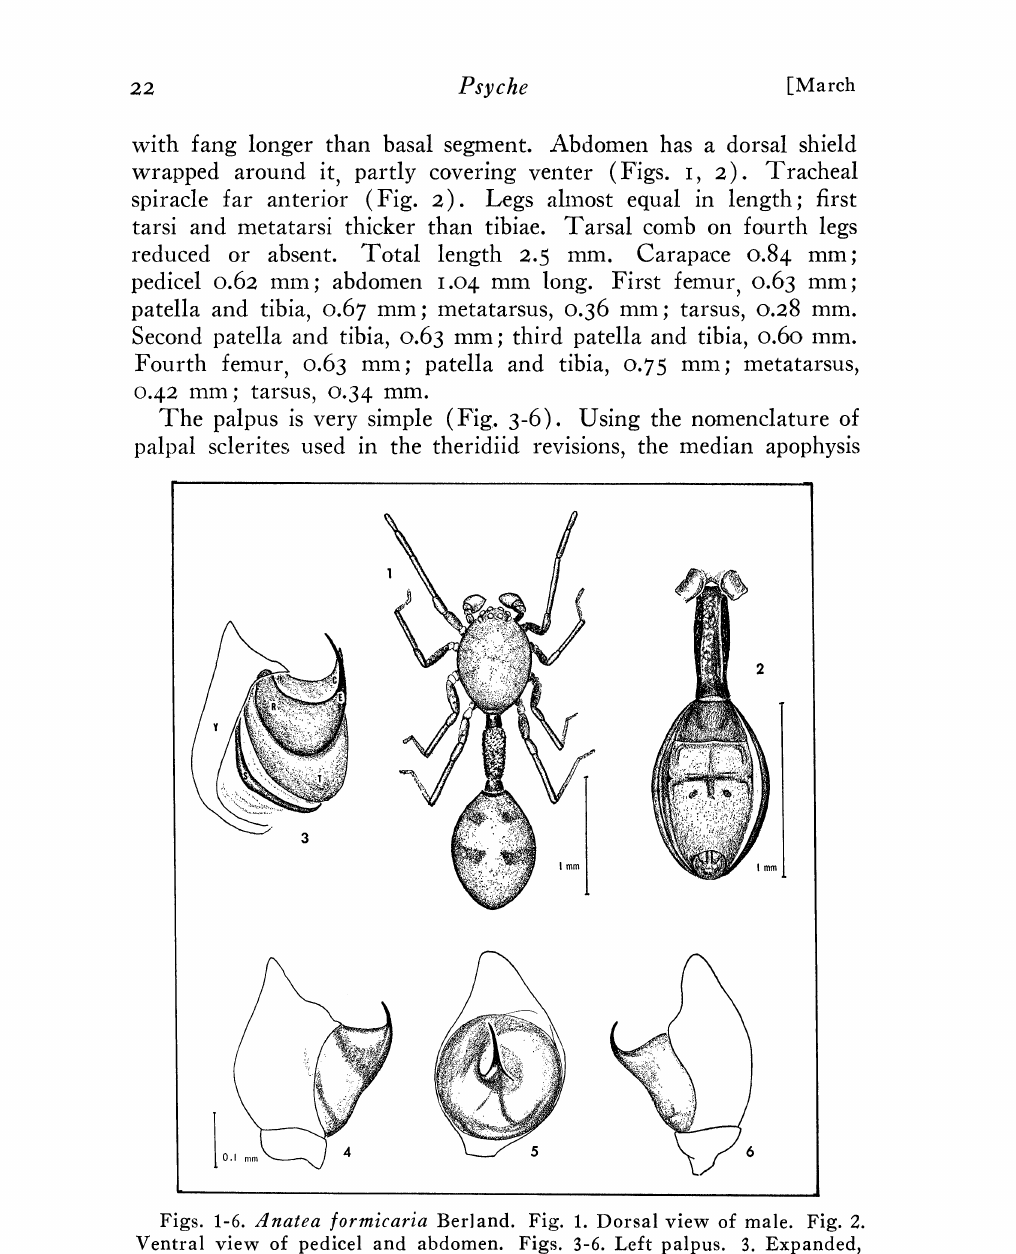
Figs. 1-6. Anatea formicaria Berland. Fig. 1. Dorsal view of male. Fig. 2. Ventral view of pedicel and abdomen. Figs. 3-6. Left palpus. 3. Expanded, mesoventral view. 4. Mesal view. 5. Ventral view. 6. Ectal view. Abbre- viations. C, conductor E, embolus S, subtegulum T, tegulum; Y,